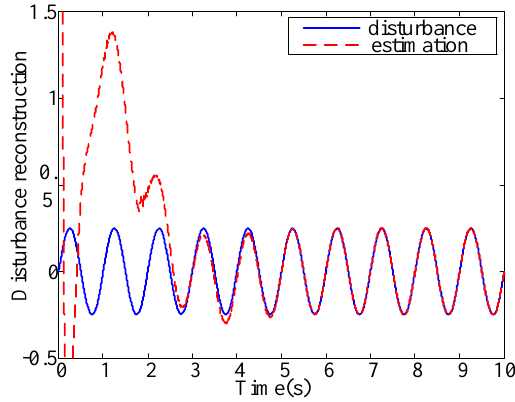
Figure 7. Continuous input recovery by PIO.